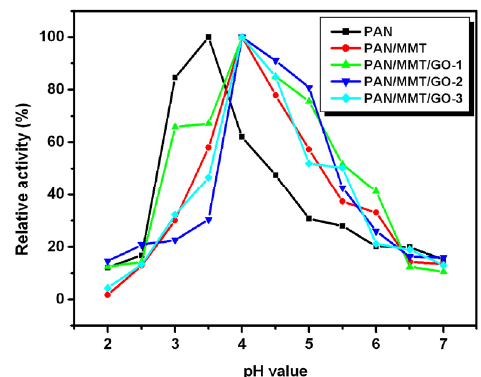
Figure 5. Optimum pH of the immobilized laccase on different supports.